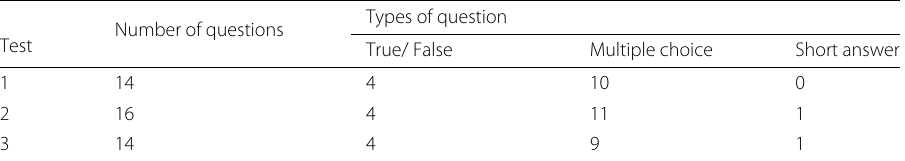
Table 7 Distribution of questions based on types of questions